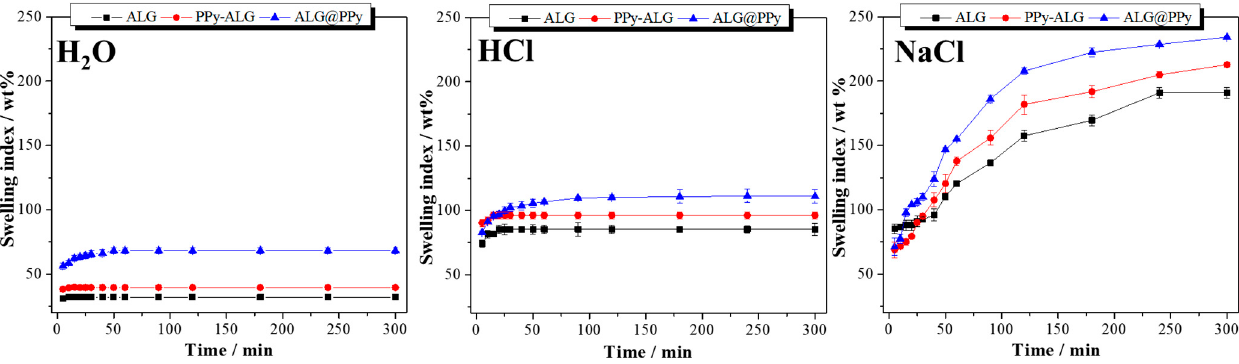
Figure 3. Swelling index (in wt%) of ALG, PPy-ALG and ALG@PPy hydrogels disks in ( left ) ultrapure water, ( center ) HCl 0.1 mol L − 1 and ( right ) NaCl 0.1 mol L − 1 (replicates = 3).